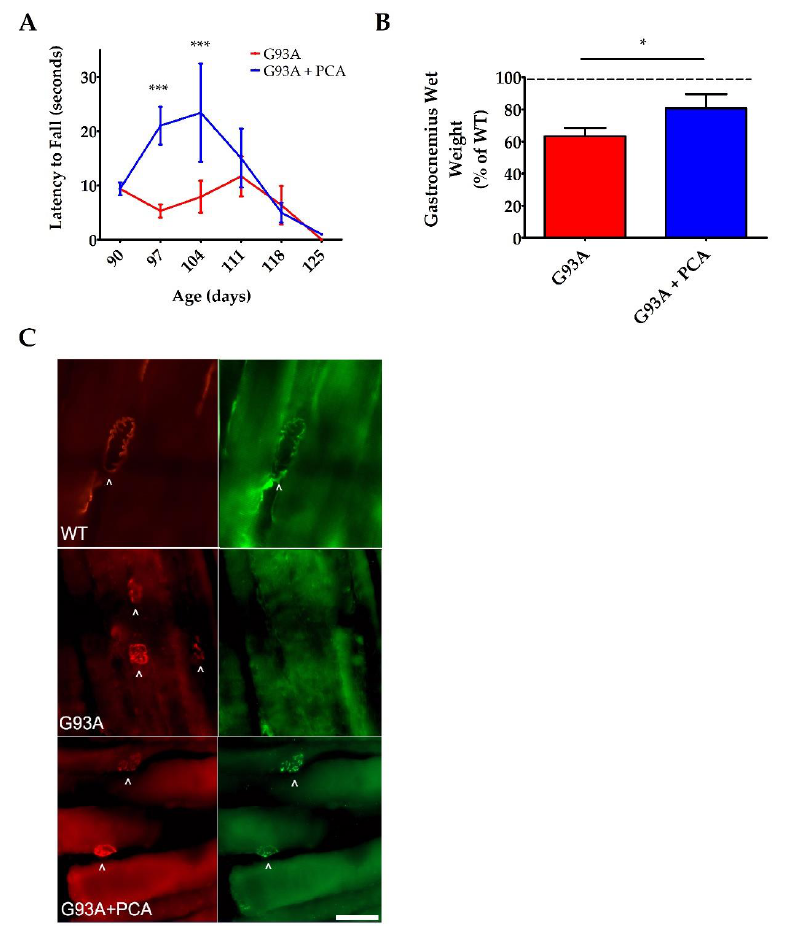
Figure 3. PCA treatment improves motor function as assessed by rotarod and also preserves gastrocnemius muscle weight and neuromuscular junction (NMJ) innervation at 105 days of age in the hSOD1 G93A mouse model of ALS. ( A ) Rotarod testing of hSOD1 G93A mice (untreated or treated with 100 mg/kg PCA beginning at disease onset). Rotarod testing was performed beginning at 90 days of age and extending through end stage and is expressed as latency to fall. Rotarod data are represented as the mean ± SEM for each time point; n = 10 mice per group. *** indicates p < 0.001 in comparison to untreated hSOD1 G93A littermate controls. All data were analyzed using an unpaired t -test at each time point. ( B ) Quantification of gastrocnemius muscle weights. Data are expressed as a percent of the wildtype (WT) littermate mouse muscle weight and are shown as the mean ± SEM; n = 7 mice per group. * indicates p < 0.05 compared to untreated hSOD1 G93A control mice (paired t -test). Mean gastrocnemius wet weight for the untreated hSOD1 G93A mouse (0.0912 ± 0.0070) is significantly decreased when compared to the WT littermate control mouse (0.1433 ± 0.0055) ( p = 0.0002; n = 7 mice